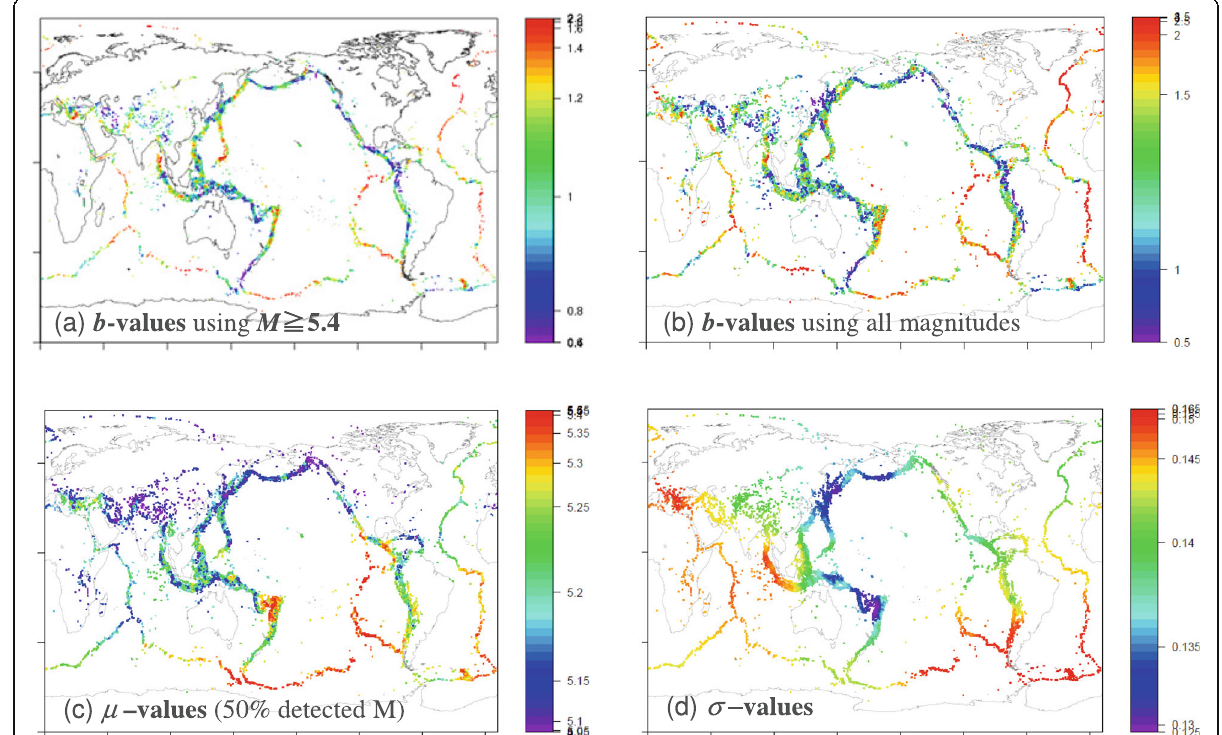
Fig. 12 Optimal MAP solutions for Global CMT catalog. a Estimated b values by using all completely detected M ≥ 5.4 earthquakes and b – d estimated b , μ , and σ values by using all detected M ≥ 0 earthquakes, respectively. Rainbow colors represent ordered estimates in respective quantities, and the estimated values are shown by the corresponding color